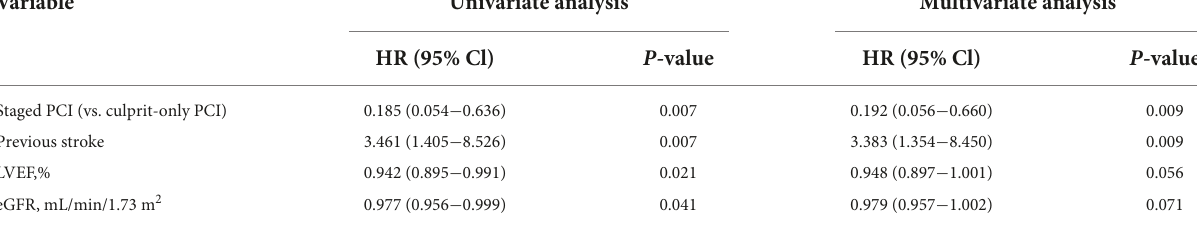
TABLE 7 Cox proportion hazards analysis for predictors of all-cause death after PSM analysis.